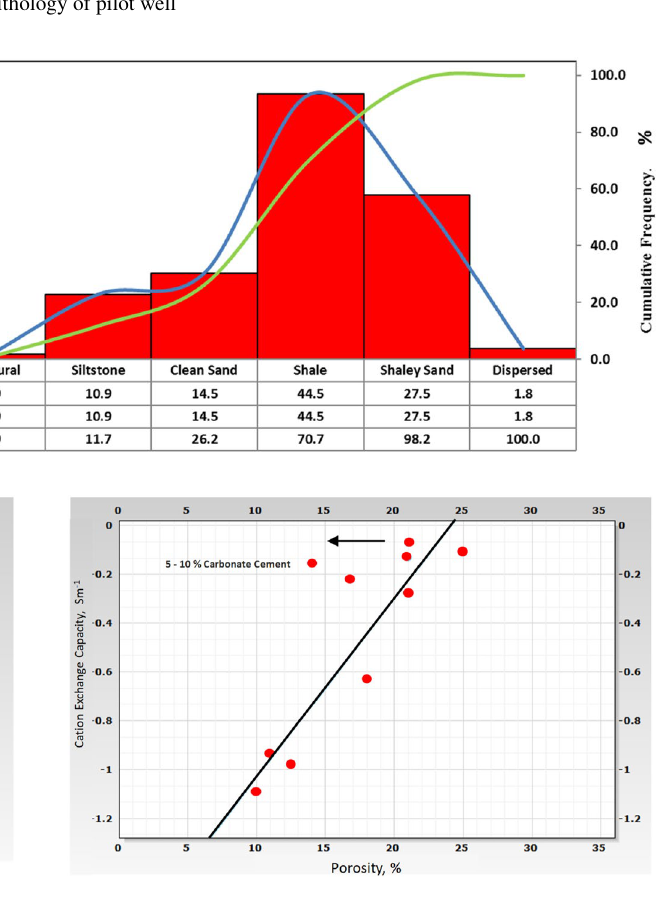
Fig. 12 CEC versus volume of shale in Bahariya reservoir